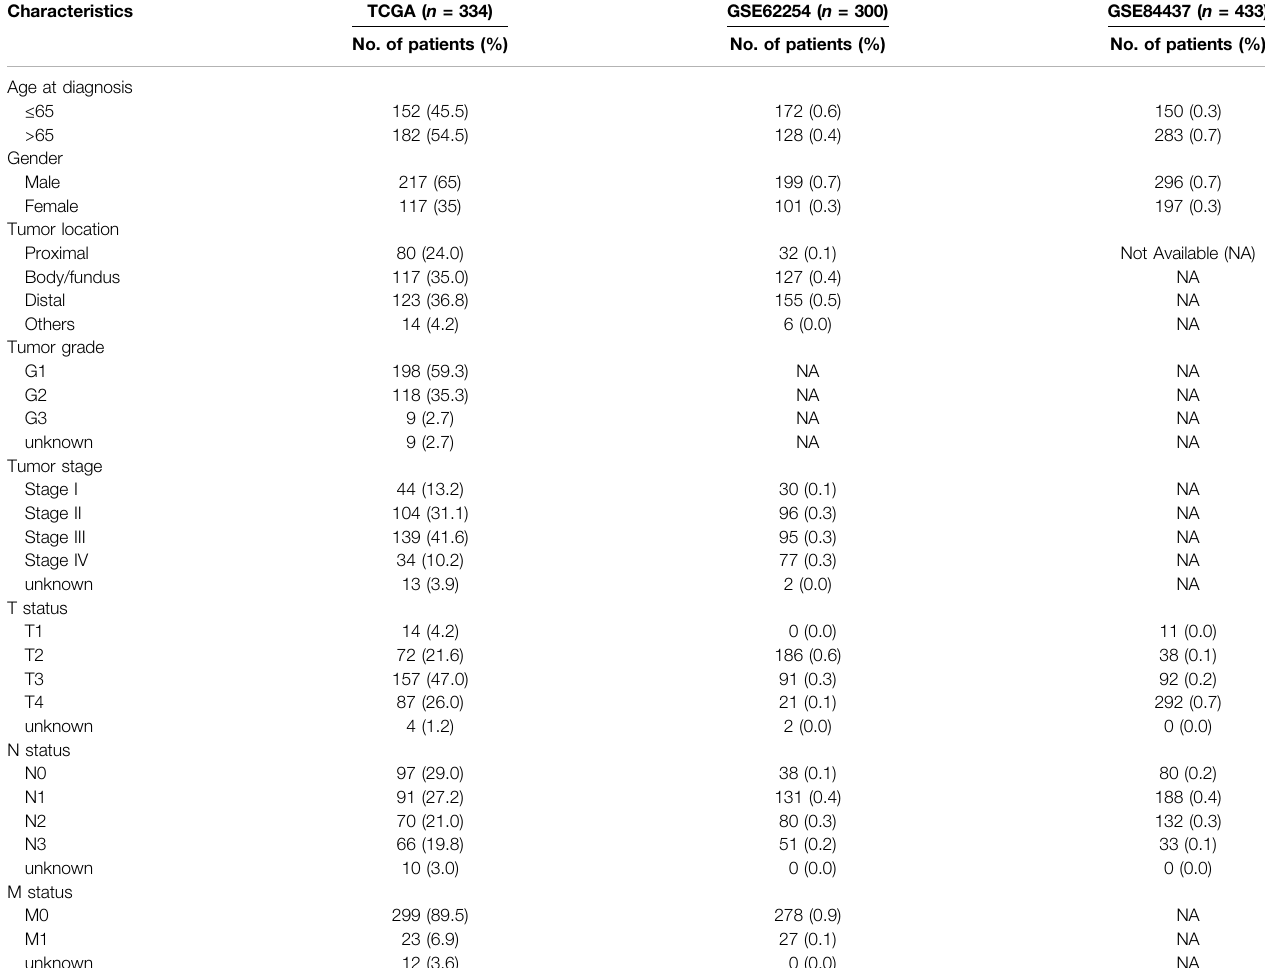
TABLE 2 | Characteristics of patients with STAD from TCGA database, GSE62254 and GSE84437.